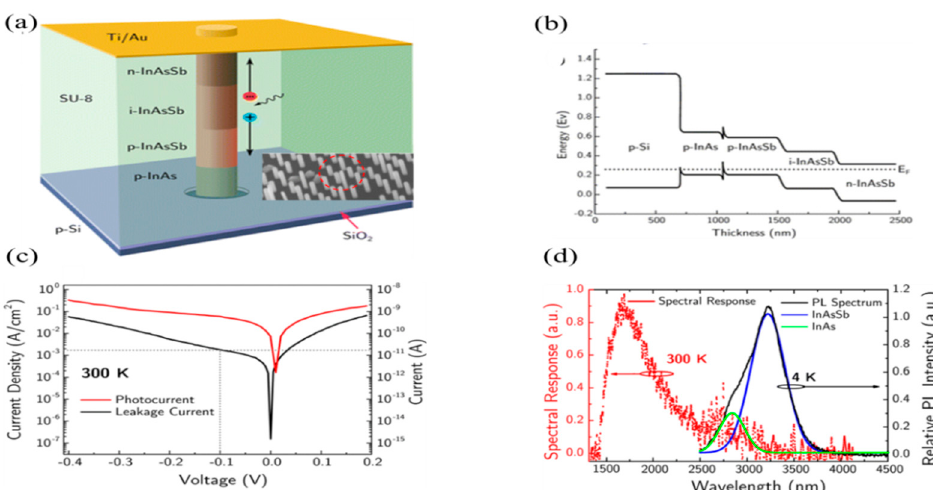
Figure 6. ( a ) The schematic of InAs 1-x Sb x nanowire with p–i–n junction vertically and the inset is the SEM image of NWs array on a p–Si substrate; ( b ) shows the cascade-like energy band alignments along the NW at different stichometry (x) values; ( c ) dark and photocurrents corresponding to 1.55 µm infrared light, and ( d ) the photo-response at different temperature in an InAs 1-x Sb x -based photodetector. (Reproduced with the permission of Reference [11]. Copyright 2016, American Chemical